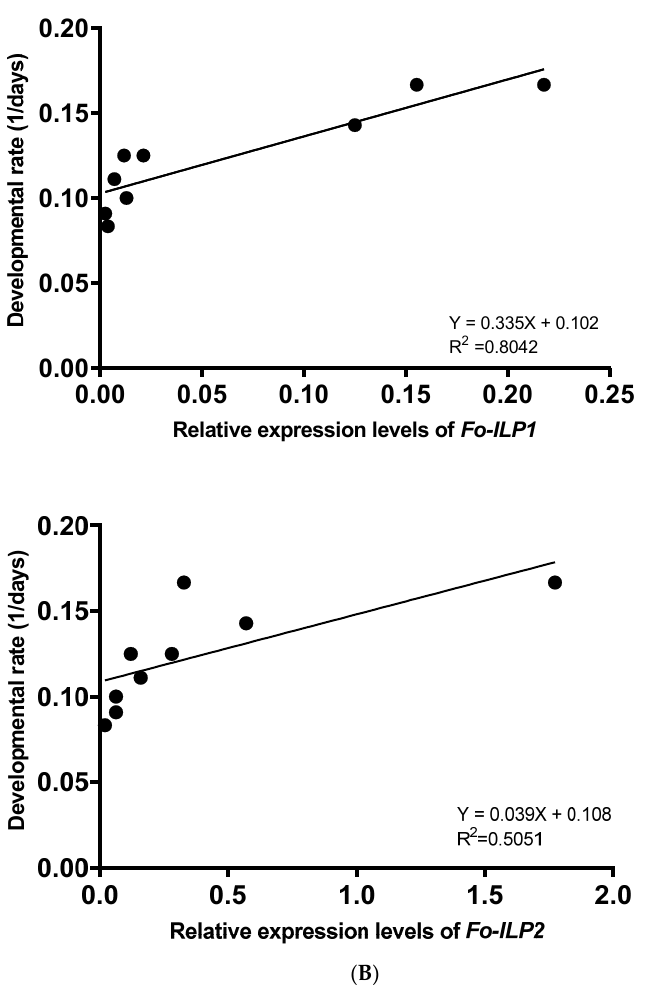
Figure 6. Influences of different varieties of hot peppers on the expressions of the two ILP genes of F. occidentalis . ‘R1’ and ‘R2’ are varieties resistant to TSWV infection. ‘CON’ represents control based on the soybean diet. Leaf disks of the two hot peppers were used for the feeding treatment of the thrips larvae. ( A ) Changes in the expression levels of the two ILPs ( Fo-ILP1 and Fo-ILP2 ) in F. occi- dentalis . RT-qPCR was performed on the first days of the second instar larvae (‘L’), pupae (‘P’), and adult females (‘F’). The letters above the standard deviation bars indicate significant differences among the means at type I error = 0.05 (LSD test). ( B ) Regression analysis between the developmen- tal rate and ILP expression levels. The developmental rate was estimated by the inverse of the de- velopmental period. ILP expression levels were obtained from the pupal stage. Each treatment used 20 larvae to measure the developmental periods.